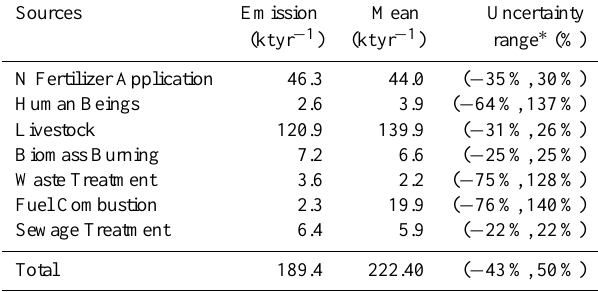
Table 6. Uncertainty in NH 3 emission estimates by source